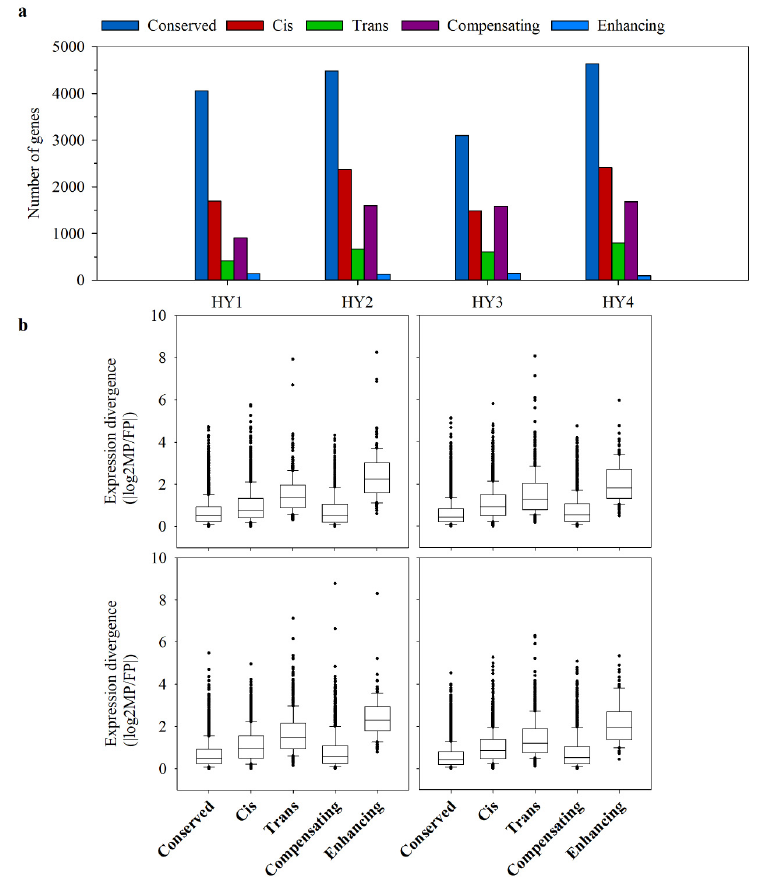
Figure 6. Cis- and trans-effects in the hybrids. ( a ) The number of genes in different regulatory categories. The “conserved” category represents the genes showing no clear cis- or trans-effects. Genes showing evidence of both cis- and trans-effects were subdivided as “compensating” and “enhancing”, where the cis- and trans-effects act in opposite directions and the same direction, respectively. ( b ) The absolute magnitude (fold-change) of parental expression divergence resulting from different regulatory effects. The median trans-effects were larger than the median cis-effects in all the four hybrids.